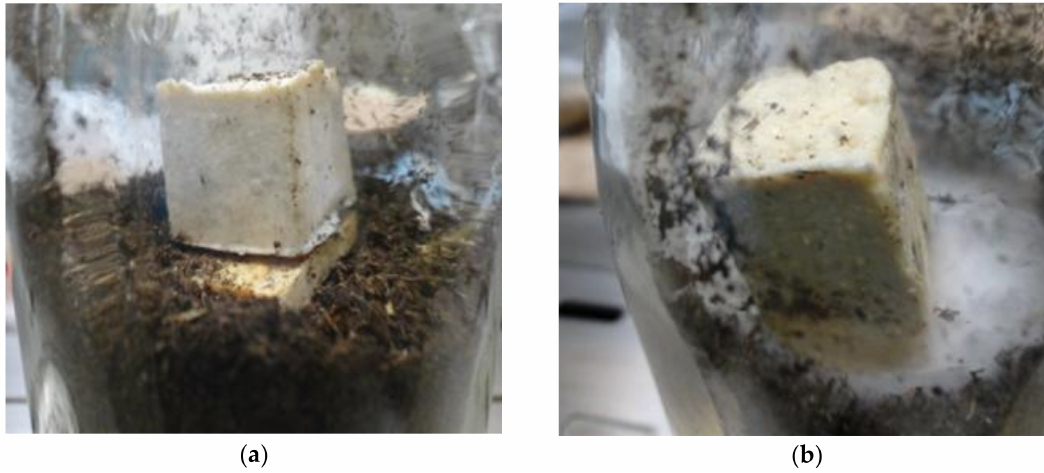
Figure 7. ASTM D-1413 standard test with Trametes versicolor of ( a ) CP22 and ( b ) CP22 with QV resin